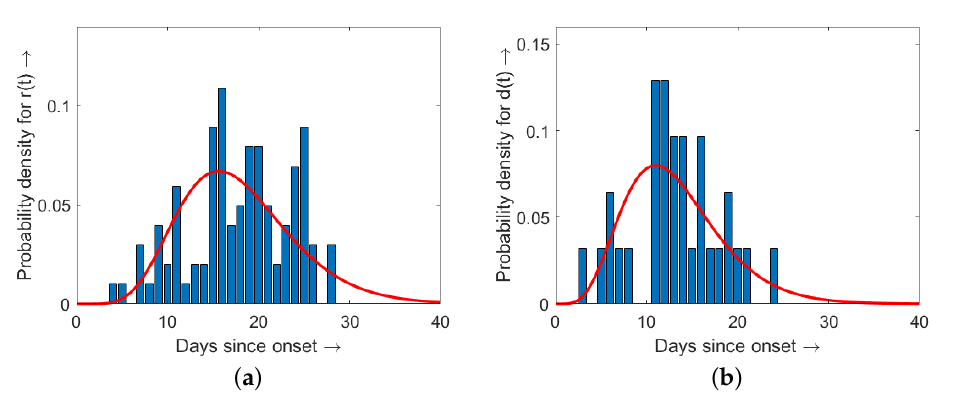
Figure A1. Probability distribution of recovery ( a ) and death ( b ) as a function of time (in days) after the onset of infection. The red curves show the best-fit gamma distributions using the function “ fitdist(:,’gamma’) ” in